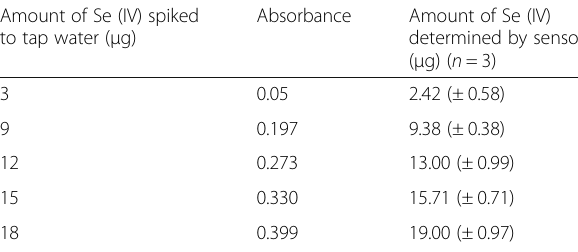
Table 2 Amount of Se (IV) determined by sensor in aqueous samples Amount of Se (IV) spiked to tap water ( μ